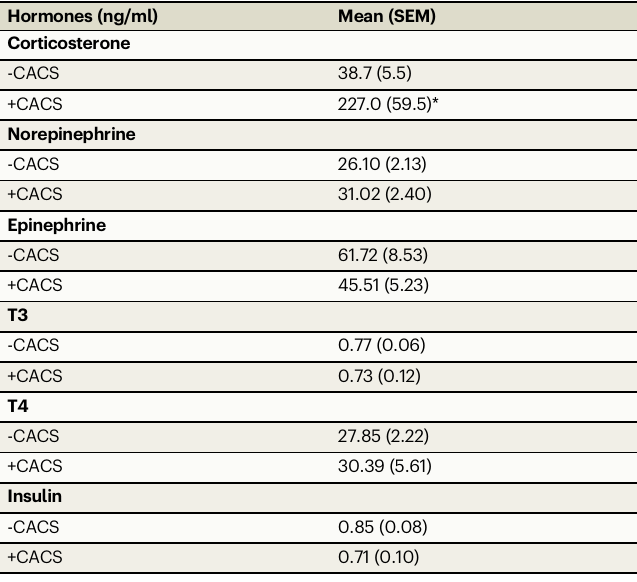
Table 1 | Circulating Hormone